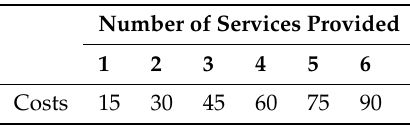
Table 2. Costs of provided services.